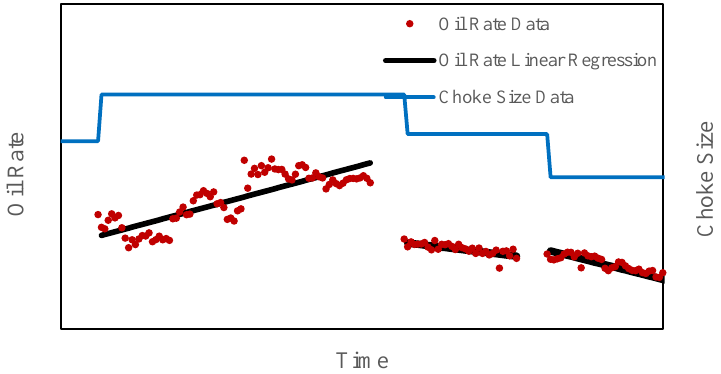
Figure 8. Time segmentation based on choke size change and well shut-down and data regression.